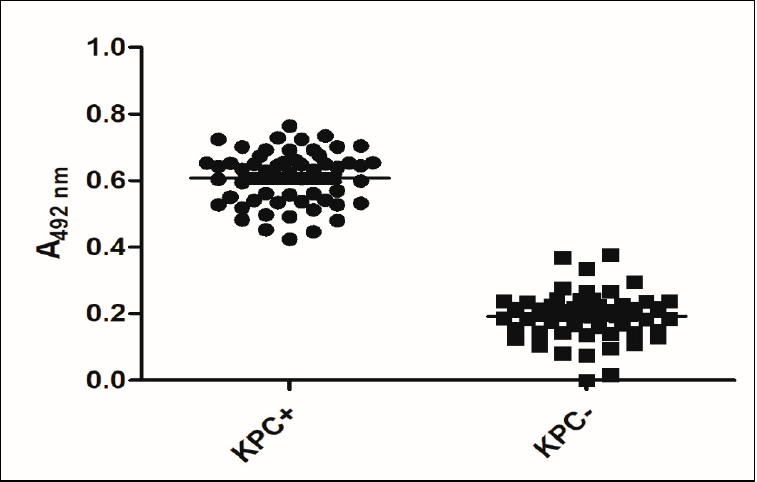
Figure 6. T-Student analysis of the KPC-ELISA-GMHB test veri fi cation. Caption: KPC+: KPC-like- producing samples. KPC-: isolates not producing KPC-like ( p -value: <0.0001).